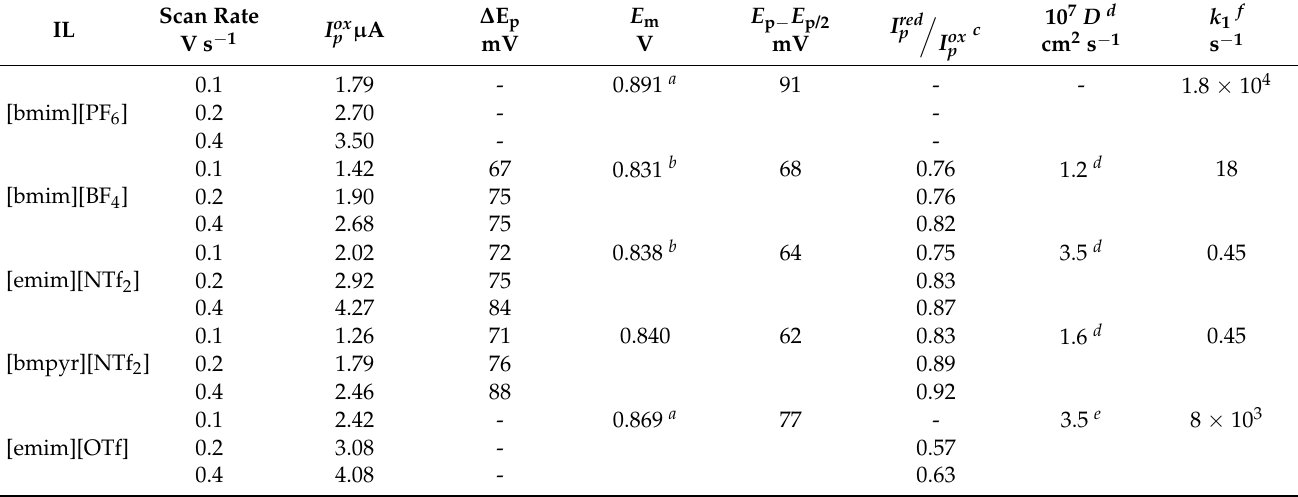
Table 1. Cyclic Voltammetric data obtained for oxidation of 5 mM 1 in ILs.